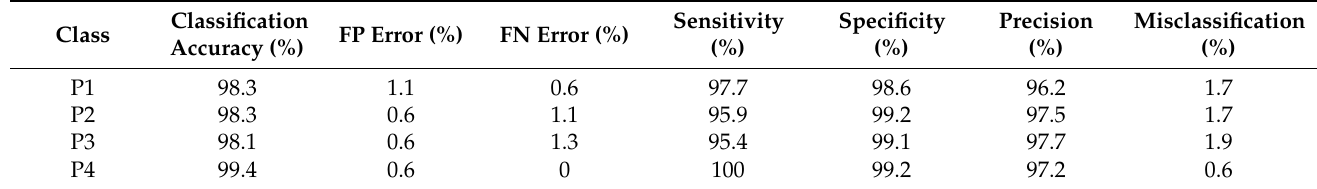
Table 7. The overall mean performance measures of the combined SNV and SNV+DT corrected data for the LDA models used to assess the validation results for the classification of patties into four